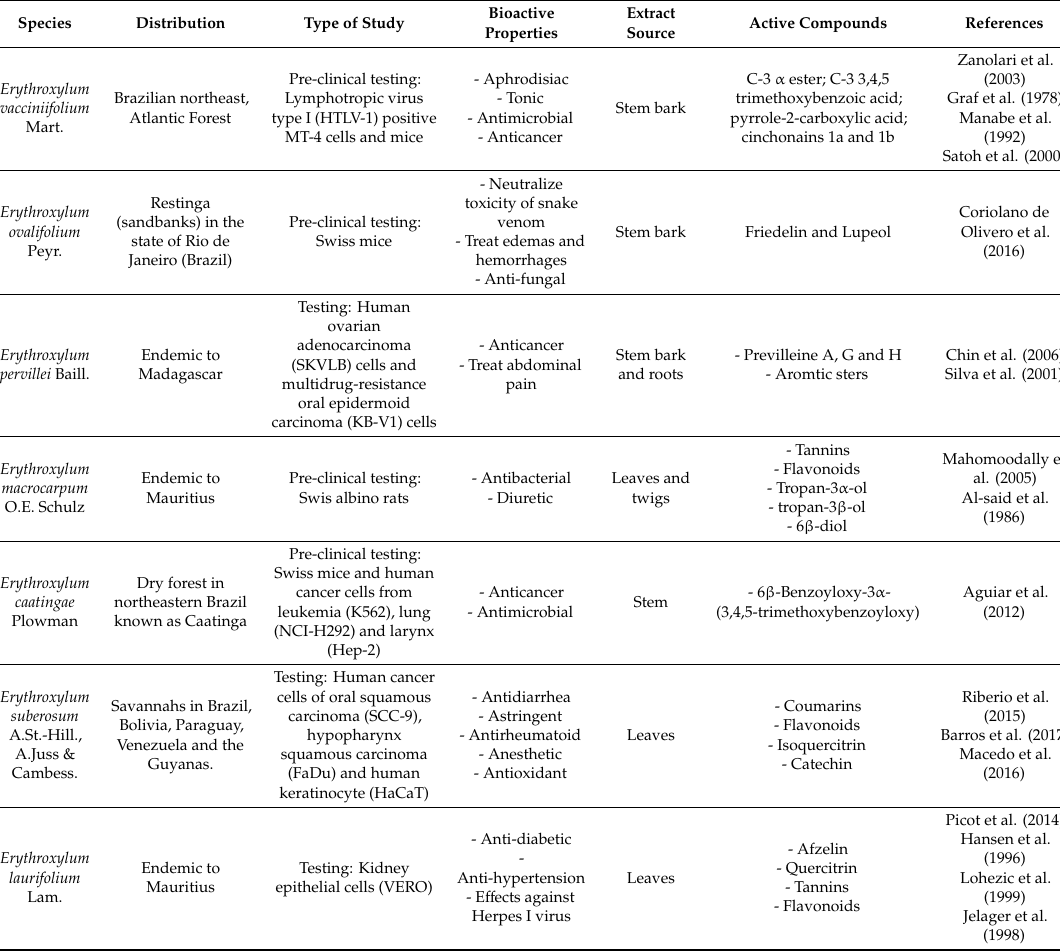
Table 1. Bioactive properties within some members of the genus